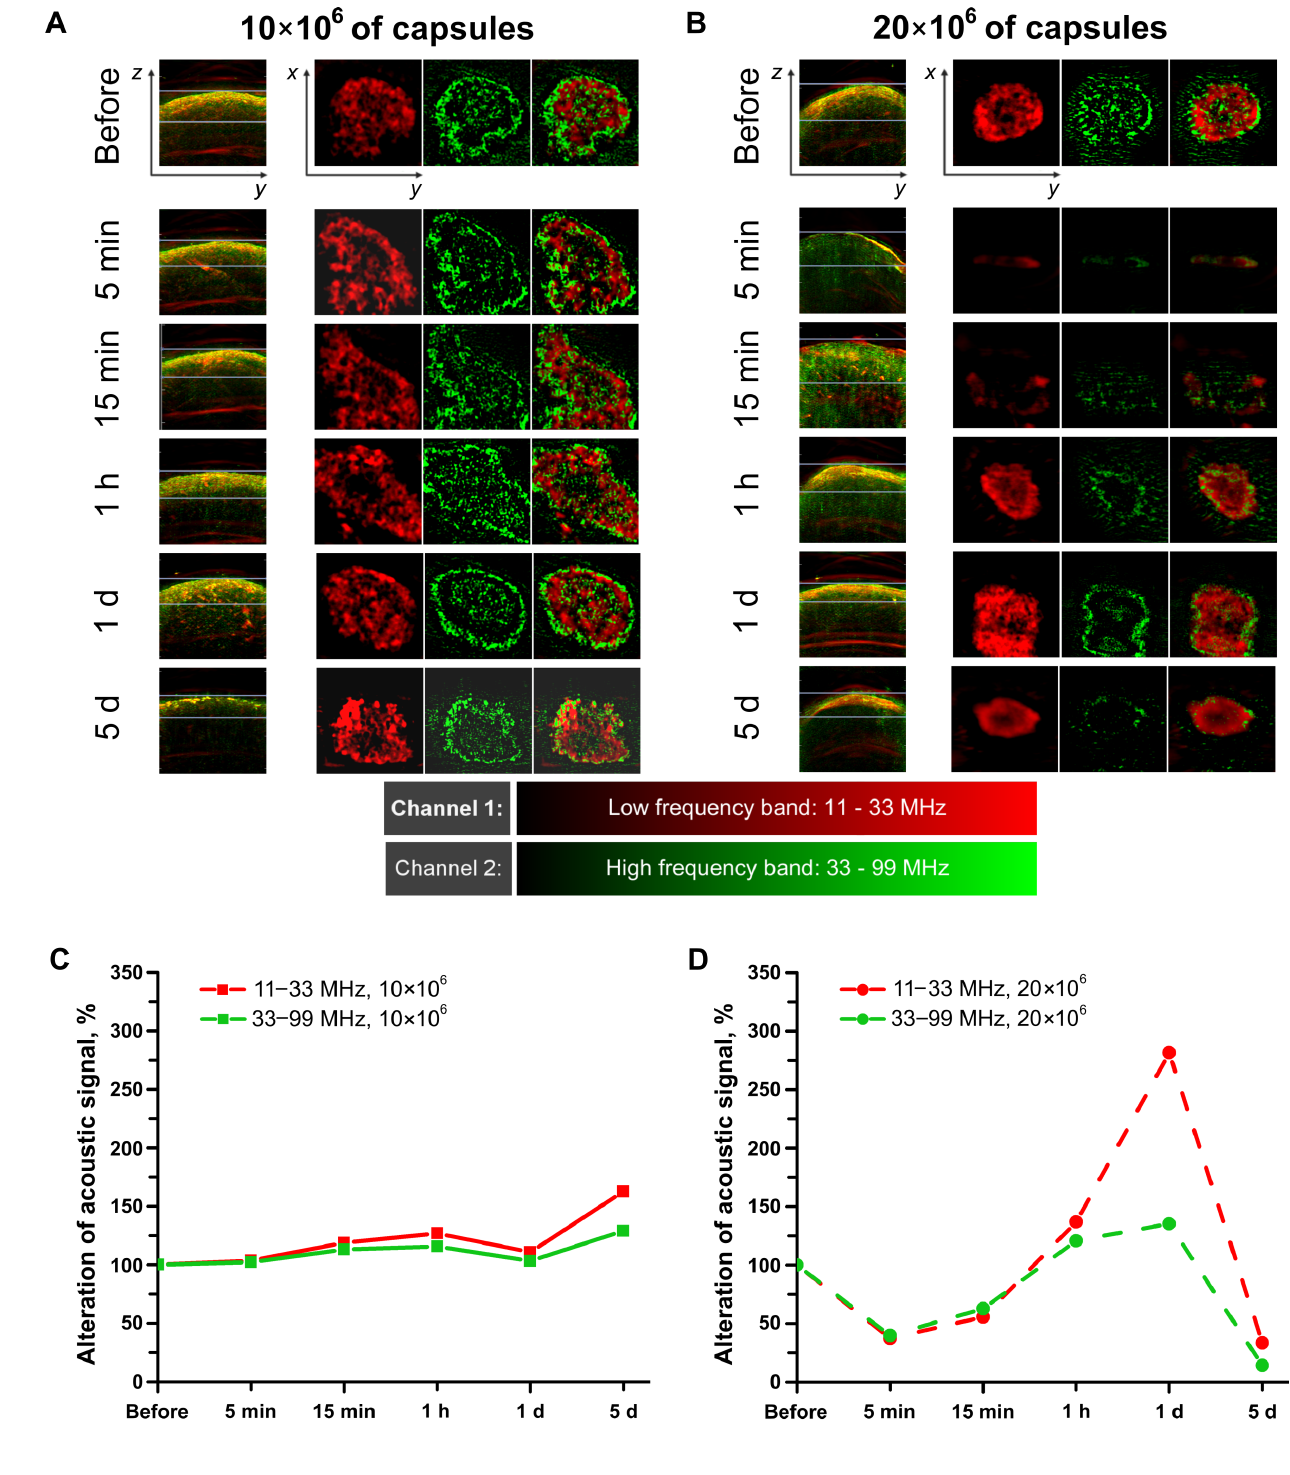
Figure 3. Optoacoustic imaging of the kidney’s vascular bed. Observation of blood circulation in the target kidney after 10 × 10 6 ( A ) and 20 × 10 6 ( B ) capsules’ injection. The side of the square for the ZY projection is 4 mm and for the XY projection is 2 mm. Alteration of the acoustic signal for the low- and high-frequency range in the target kidney after 10 × 10 6 ( C ) and 20 × 10 6 ( D ) capsules’